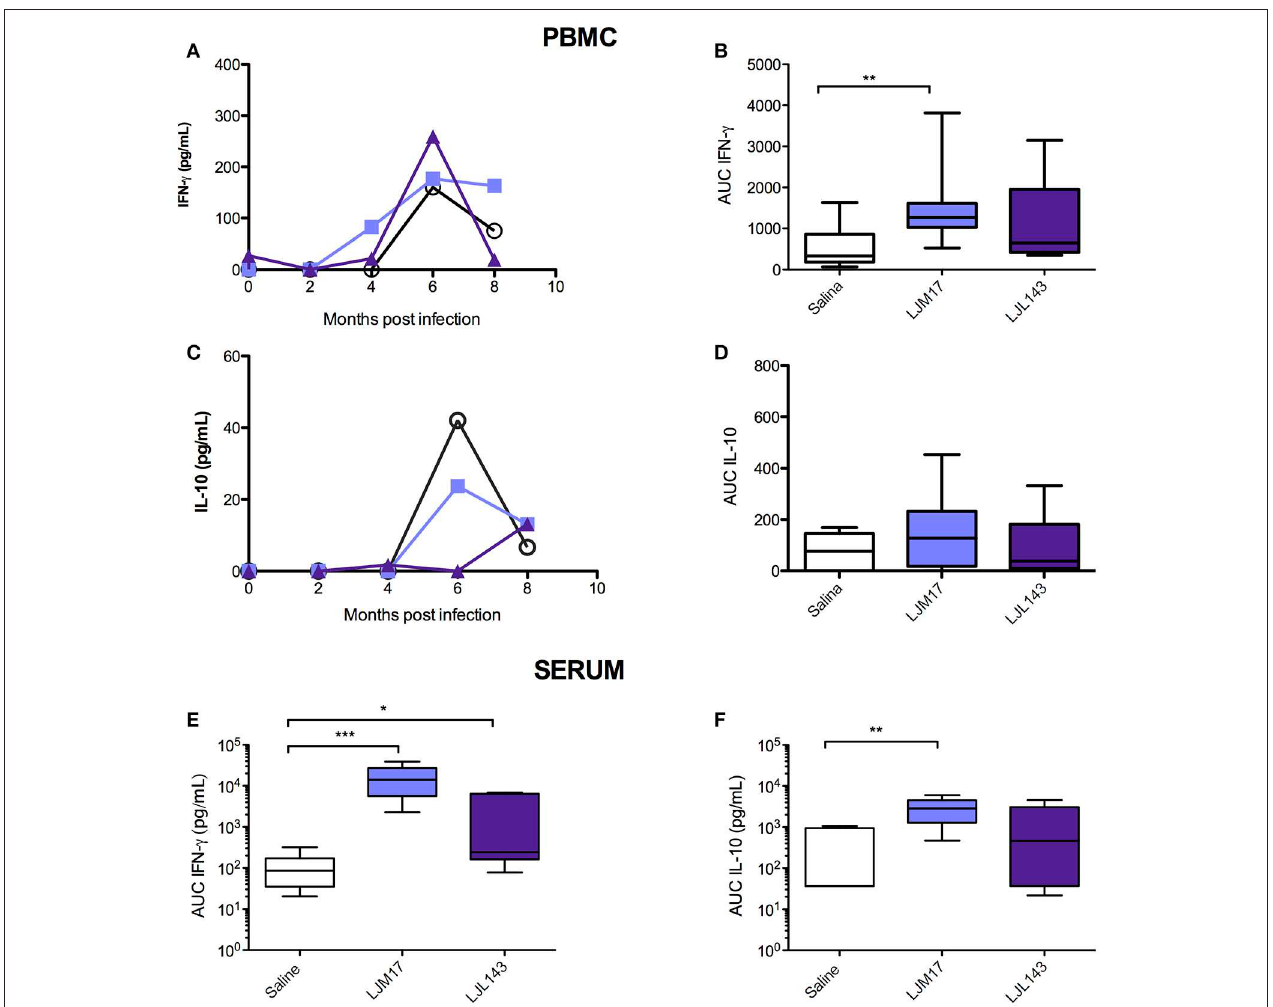
FIGURE 3 | Detection of IFN- γ and IL-10 in PBMC culture supernatant and in sera from immunized dogs and controls challenged with L. infantum . Beagle dogs ( n = 10 animals/group; total of 30 dogs) were immunized following vaccination strategies described in the methodology section. Thirty days after the final immunization, dogs were challenged with L. infantum in the presence of L. longipalpis saliva. PBMCs from immunized and control animals were collected at T0 (15 days after immunization), and every 2 months until 8 months after infection„ then stimulated with L. infantum (1:10); supernatants were collected after 24 (IL-10) and 48 (IFN- γ ) hours and analyzed by ELISA to detect IFN- γ and IL-10. Sera from immunized and control animals were collected at T0, T1 and T2 to detect IFN- γ and IL-10 by the Luminex technique. (A) PBMC IFN- γ , (B) PBMC IFN- γ AUC (C) PBMC IL-10, (D) PBMC IL-10 AUC, (D) sera IFN- γ AUC (E) sera IL-10 AUC, (F) sera Luminex technique. For the statistical analysis, the area under curve was calculated, followed by the Kruskall-Wallis test with Dunns post-test (* P < 0.05, ** P < 0.005, *** P < 0.0001).